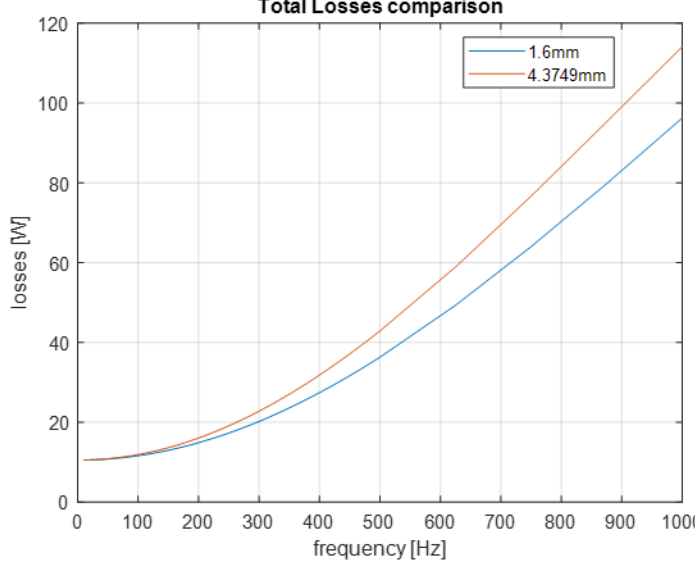
Figure 17. Slot opening total losses comparison, wt = 2